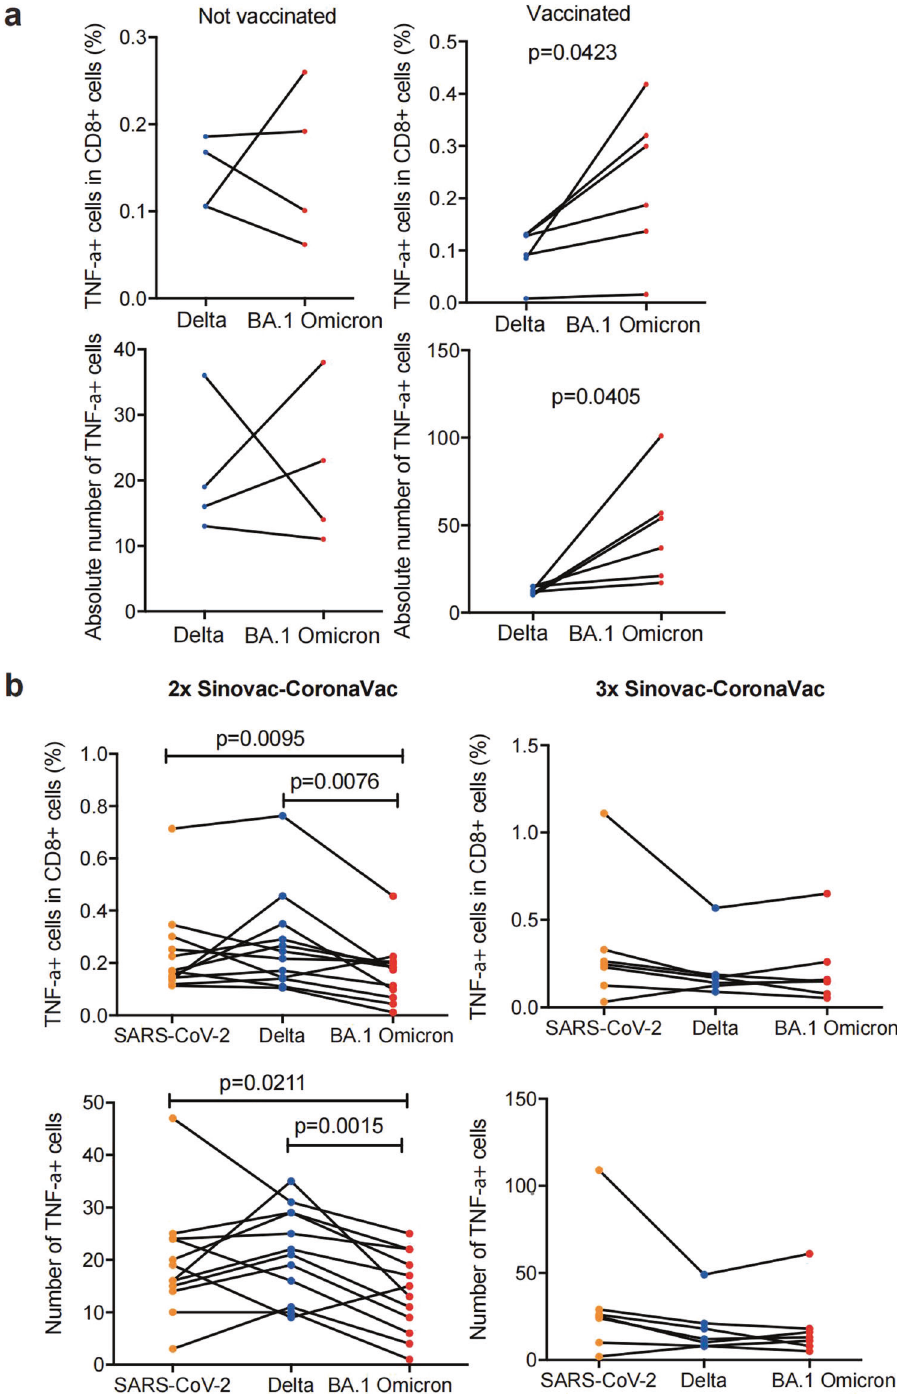
Fig. 2 Immune response of Omicron to Delta-speci fi c CD8 + T cells. a (Top) The percentage of TNF- α + cells in total CD8 + T cells in vaccinated convalescent individuals ( n = 6) and convalescent individuals without vaccination ( n = 4). (Bottom) The absolute number of TNF- α + cells in vaccinated convalescent individuals ( n = 6) and convalescent individuals without vaccination ( n = 4). b (Top) The percentage of TNF- α + cells in total CD8 + T cells in 2-doses vaccinees ( n = 12) and 3-doses vaccinees ( n = 7). (Bottom) The absolute number of TNF- α + cells in total CD8 + T cells in 2-doses vaccinees ( n = 12) and 3-doses vaccinees ( n = 7). Data are represented as mean ± SEM, p -value was determined by the wilcoxon rank sum test not signi fi cantly alter the frequency of TE and regulatory T cells 3-dose vaccinees were stimulated with aAPCs presented with (Tregs) (Fig. 4a, b). However, BA.1 Omicron stimulation produced spike proteins of SARS-CoV-2, Delta and BA.1 Omicron, respec- larger fraction of CD8 + T effector memory cells (TEM) (Fig. 4c). tively. Post-stimulation cells were analyzed by fl ow cytometry. This indicated that BA.1 Omicron stimulation preferentially When compared with SARS-CoV-2, BA.1 Omicron stimulation did Signal Transduction and Targeted Therapy (2023)